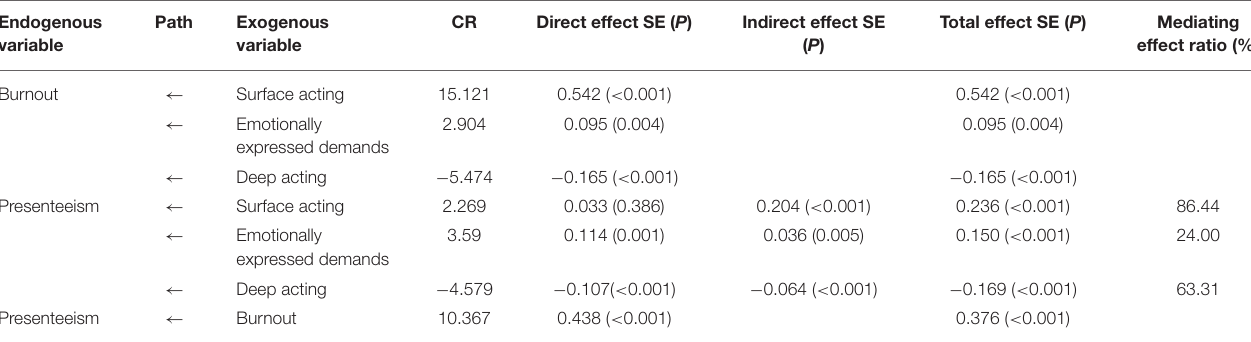
TABLE 4 | Standardized estimates, critical ratios, and standardized direct, indirect, and total effect and mediating effect ratio. Endogenous